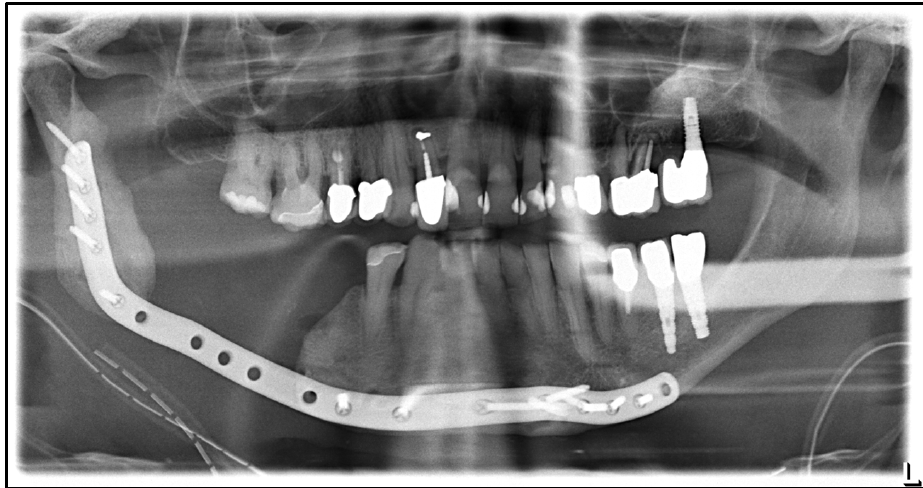
Figure 2. Dental X-ray after mandibular continuity resection and osteosynthesis with a patient-specific plate, August 2018.